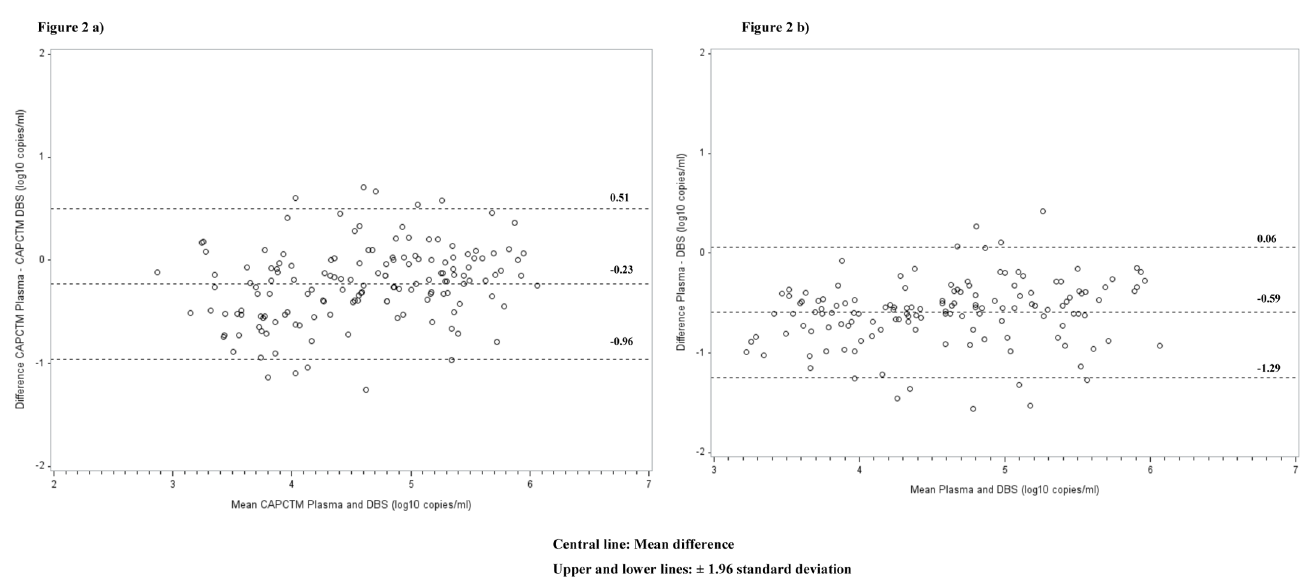
Fig 2. Bland-Altman analysesto evaluate agreement in HIV-1 (VL) quantification among plasma and dried blood spot specimens collected from patients visiting Nyanza patient support centersand tested with CAP/CTM and Abbott. The difference betweenthe reference and the comparisonspecimen type were plotted againstthe averageof the reference group and the comparisonspecimen type a ) CAP/CTM DBS VL; b ) Abbott DBS VL.